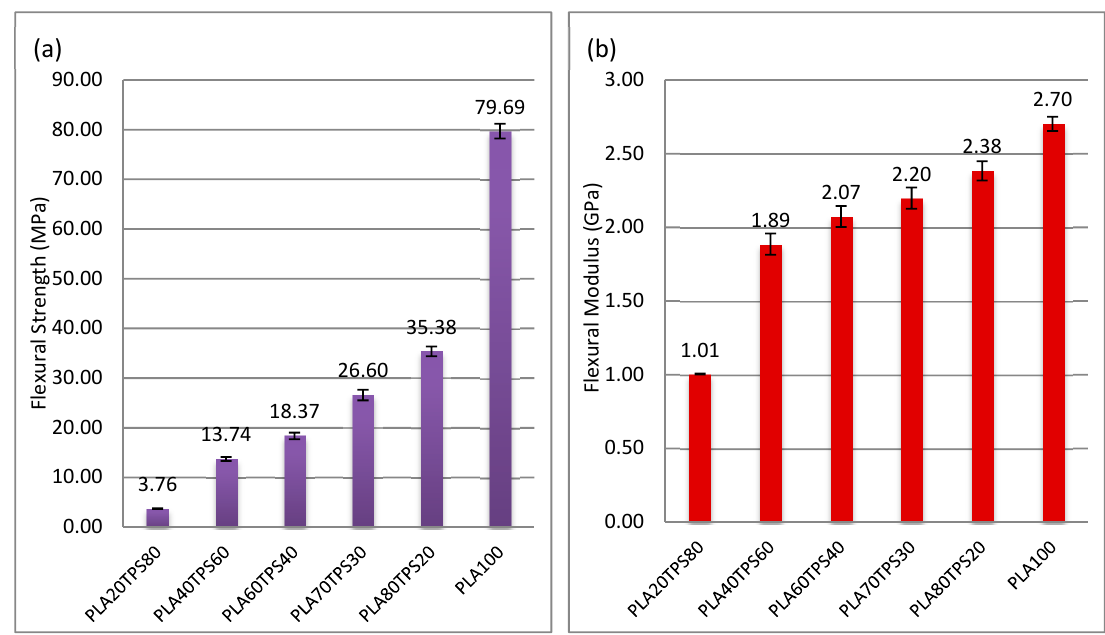
Figure 7. Flexural load–displacement curves of PLA100 and PLA/TPS blend bionanocomposites.